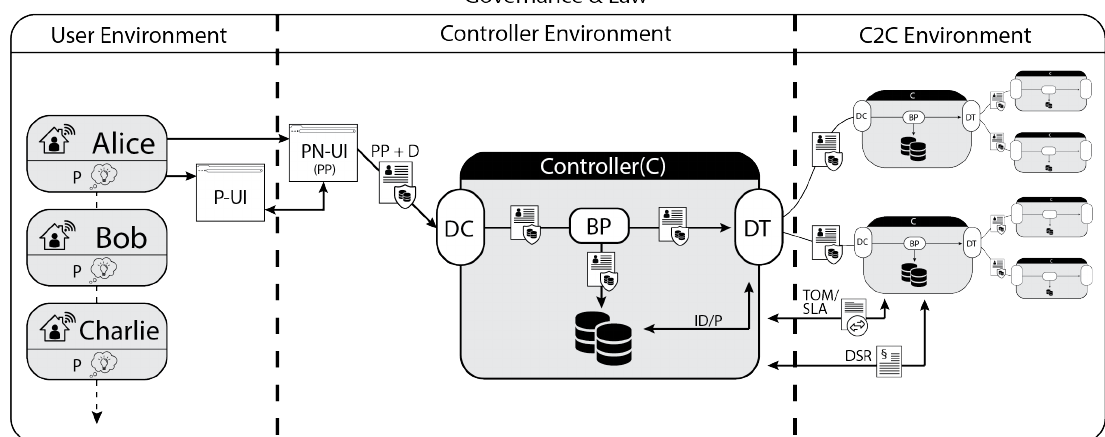
Figure 2. Personal privacy workflow. User preferences (P) are defined over Preference User Interfaces (P-UIs) and matched against privacy policies (PPs) which are presented and negotiated by Policy Negotiation User Interfaces (PN-UIs). Privacy policies and data (PP + D), so-called sticky policies, are used by controllers for Data Collection (DC), Business Processes (BPs) and Data Transfer (DT). At (DT) data are technically protected by Inference Detection and Prevention (ID/P) and legally by Technical and Organisational Measures (TOMs), Service Level Agreements (SLAs) and Data Subject Rights